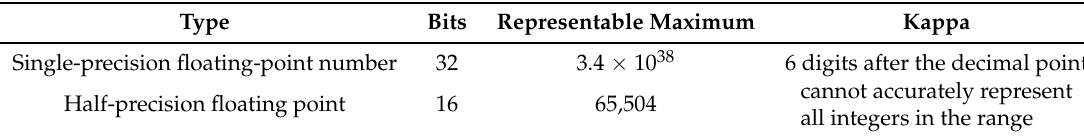
Table 4. Comparsion of single-precision float with half-precision float.